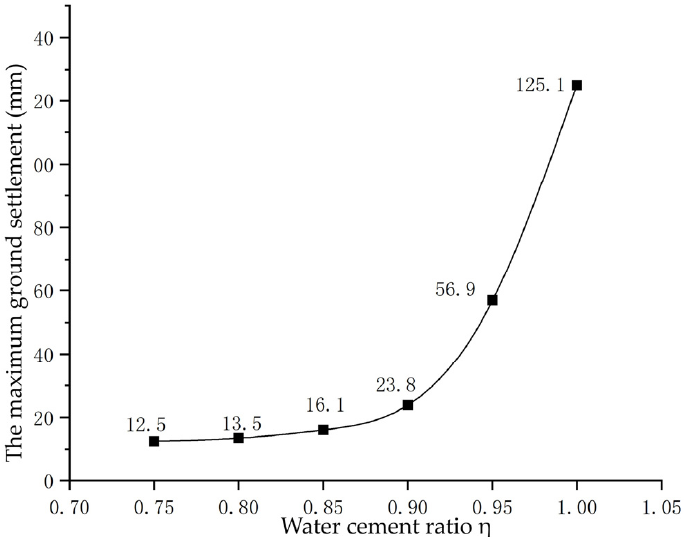
Figure 20. The relationship between the maximum ground settlement and the slurry water–cement ratio η .